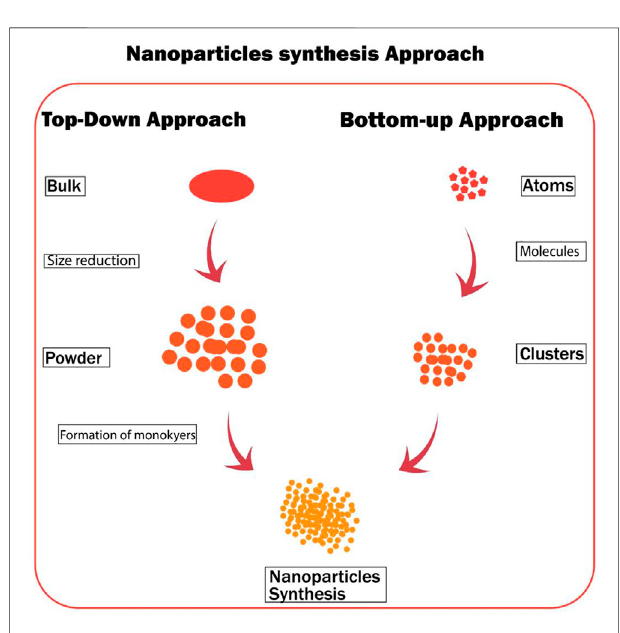
FIGURE 2 | Physical and chemical approaches of nanoparticles synthesis.